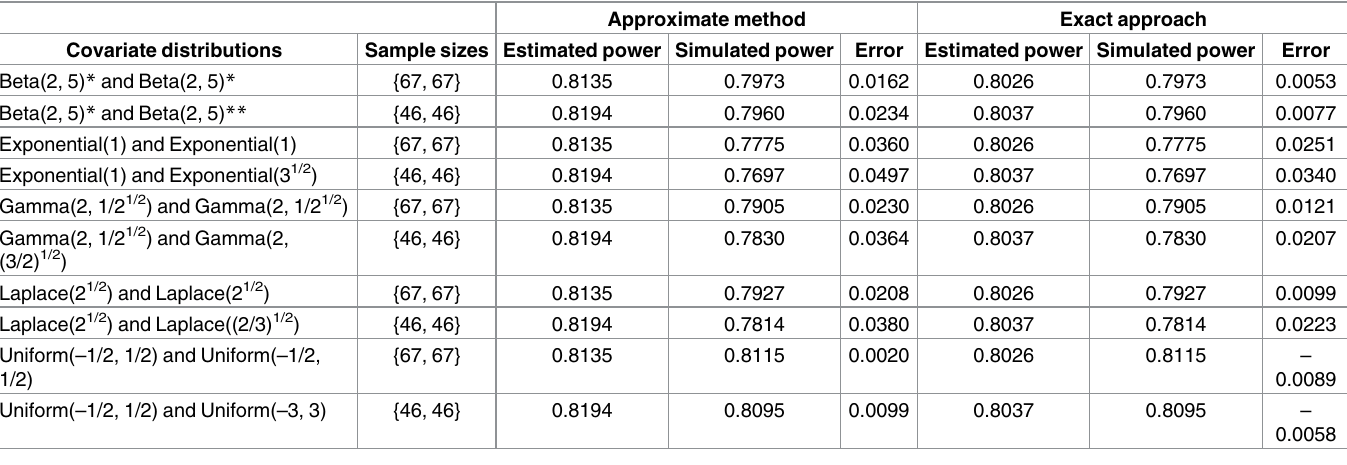
Table 3. Computed sample size, estimated power, and simulated power when δ = 0.50, Type I error α = 0.05, and nominal power 1 – β =